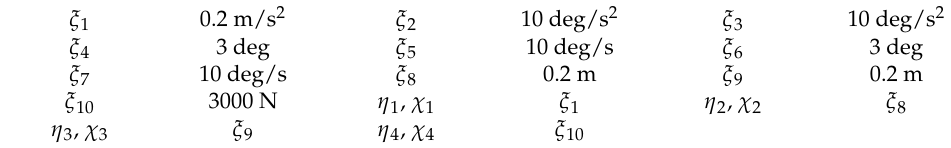
Table 2. Maximum allowable values in LQ cost function.